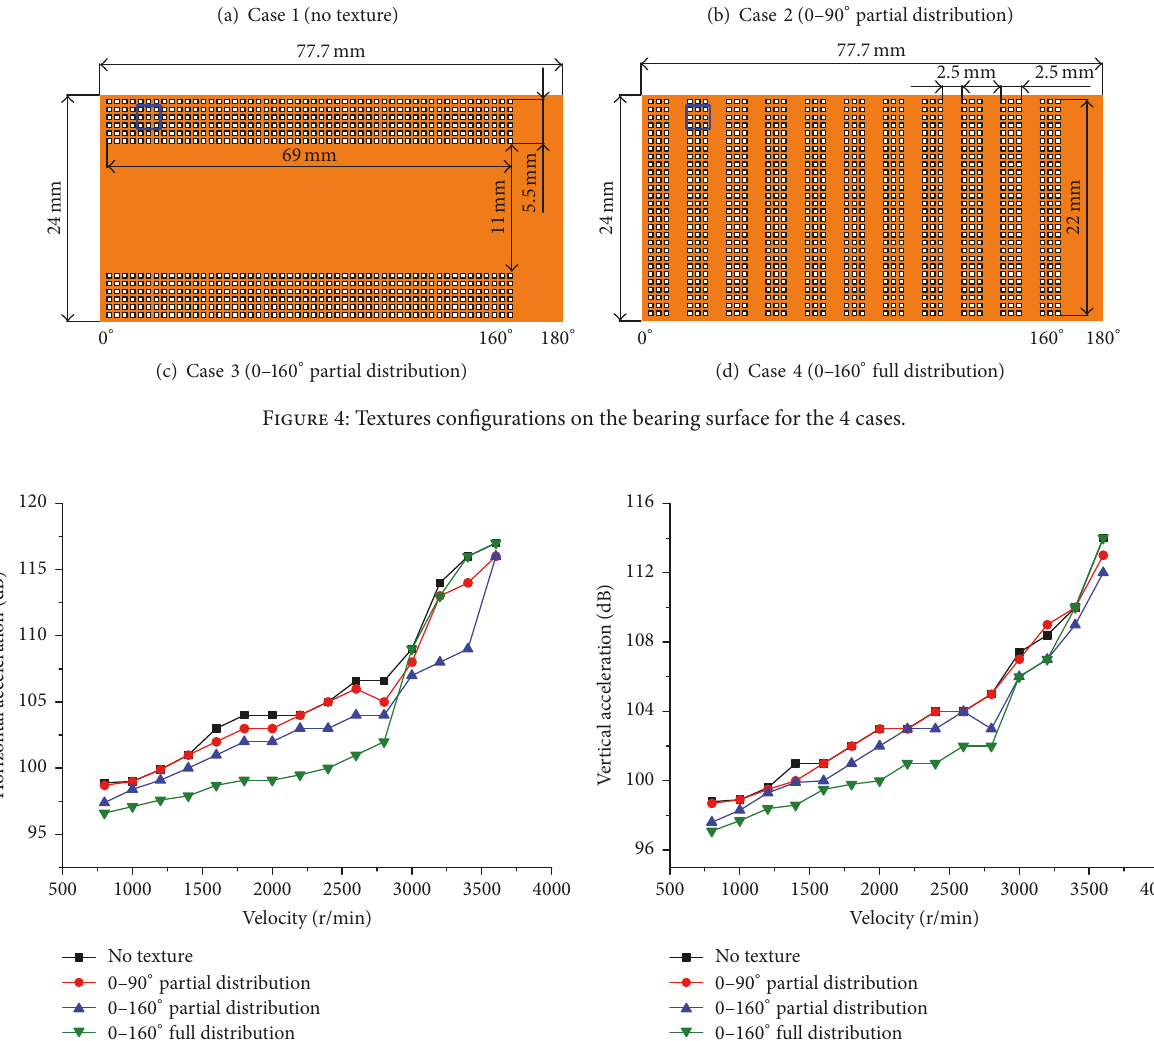
Figure 5: Acceleration amplitude of bearing housing: (a) horizontal direction; (b) vertical